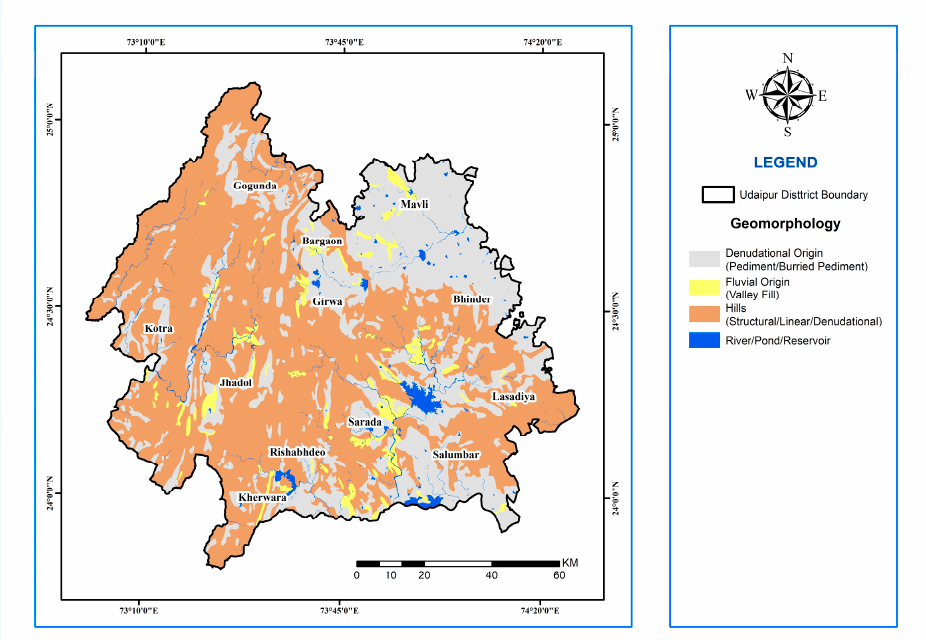
Figure 5. Geomorphological classes of the study area.